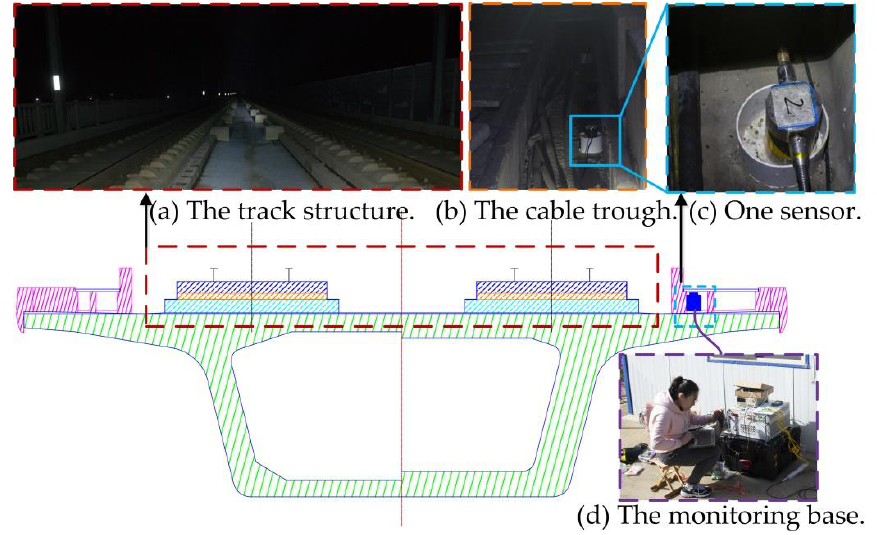
Figure 5. The field deployment of vibration monitoring system.